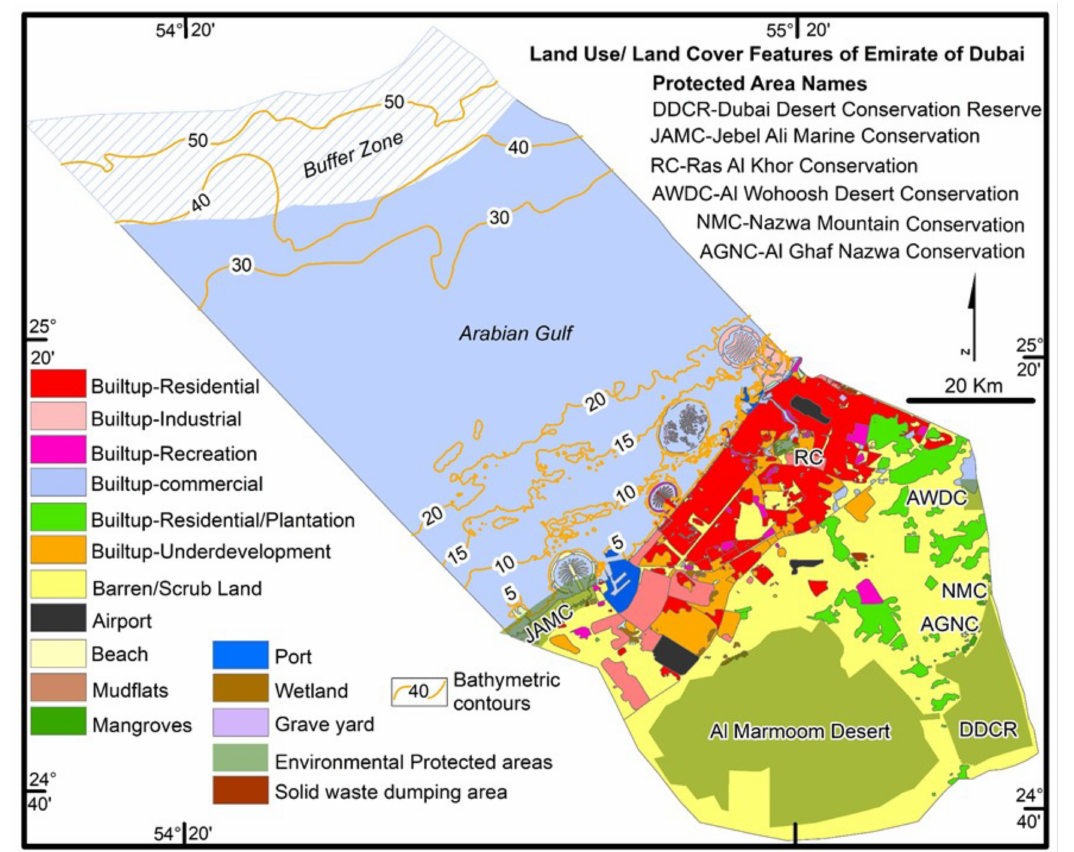
Figure 7. A comprehensive land use/land cover map of